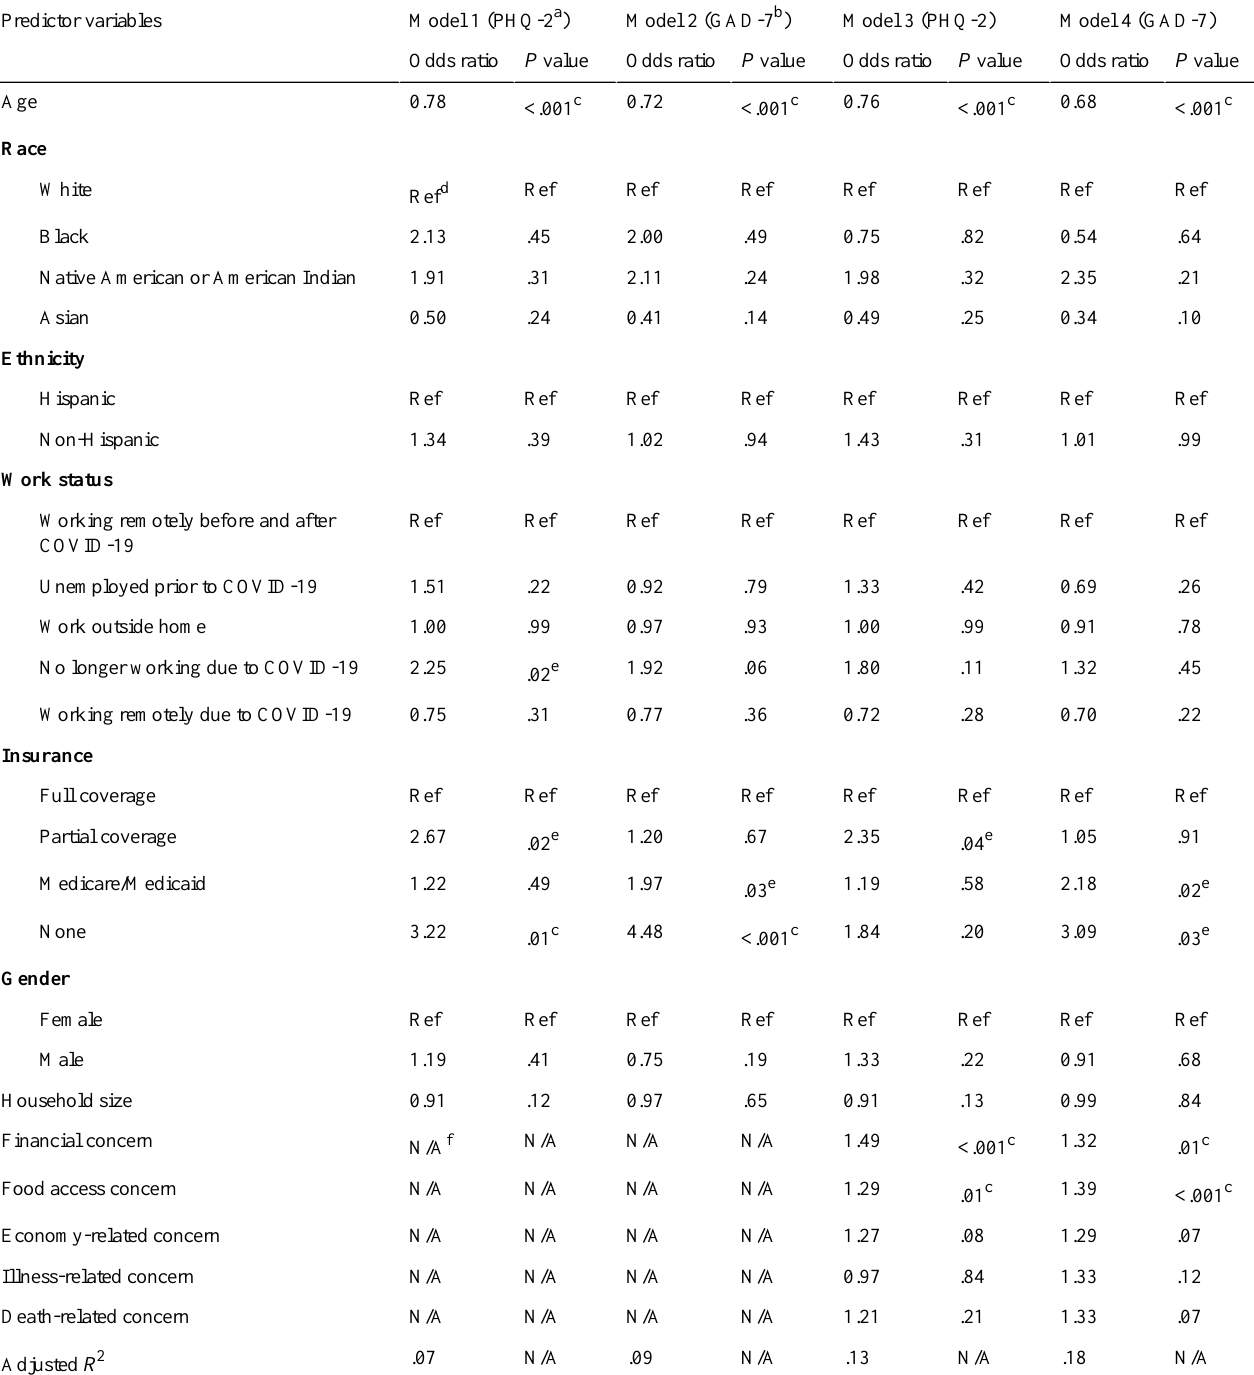
Table 2. Logistic regression models showing associations between depression (Models 1 and 3), anxiety (Models 2 and 4), demographic variables, and sources of concern